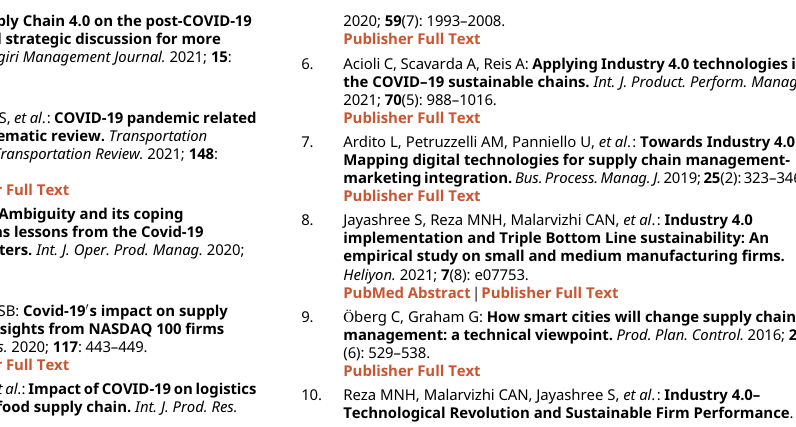
Figshare: PRISMA Checklist_The Implications of Industry 4.0 on Supply Chains Amid the Covid 19 Pandemic – A Systematic Literature Re.docx, https://doi.org/10.6084/m9.figshare.16602356. Data are available under the terms of the Creative Commons Attribution 4.0 International license (CC-BY